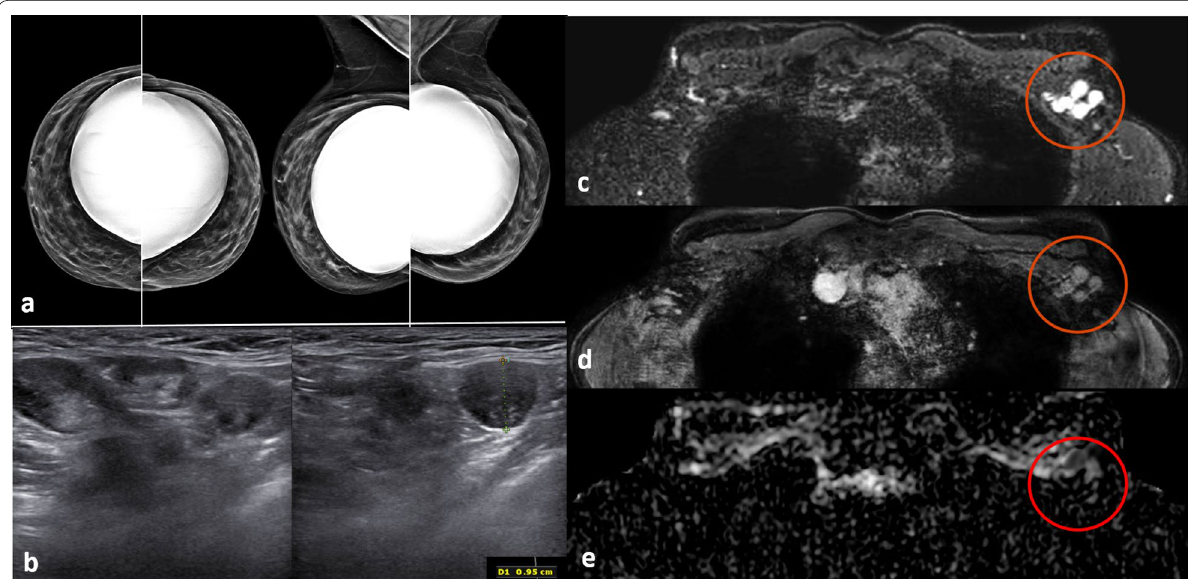
Fig. 2 Screening mammography performed in a 44‑year‑old woman with a positive family history for breast cancer (mother and aunt), bearing implants for aesthetic purposes. Mammography ( a ) was considered negative. Breast ultrasonography was also performed because of her family history and high breast density (ACR category d ). While ultrasonography was negative for both breasts, multiple round, enlarged, hypoechoic lymph nodes (measuring up to 1 cm in axial diameter), with a thickened (< 3 mm) cortex, were seen in the left axilla ( b ). There were no skin changes and there was no history of any infection or trauma. On the right side, axillary lymph nodes were normal. Because of her family history and the presence of breast implants, magnetic resonance imaging was performed ( c T2‑weighted short‑time inversion recovery; d fat‑sat contrast‑enhanced T1‑weighted gradient‑echo; e apparent diffusion coefficient map). No suspicious mass or non‑mass lesions were seen in both breasts. Implants showed no signs of rupture (not shown). In the left axilla, multiple enlarged lymph nodes were well visible in c and d (red circles); on the apparent diffusion coefficient map ( e , red circle), they mainly exhibited low signal (restricted diffusivity). When an ultrasound‑guided biopsy of the